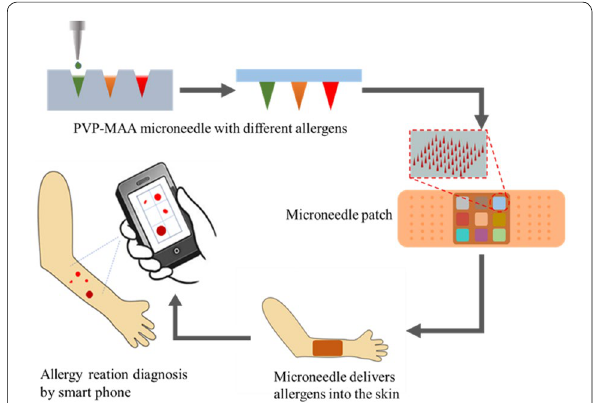
Fig. 1 The concept of using dissolving microneedle patch to facilitate allergy testing